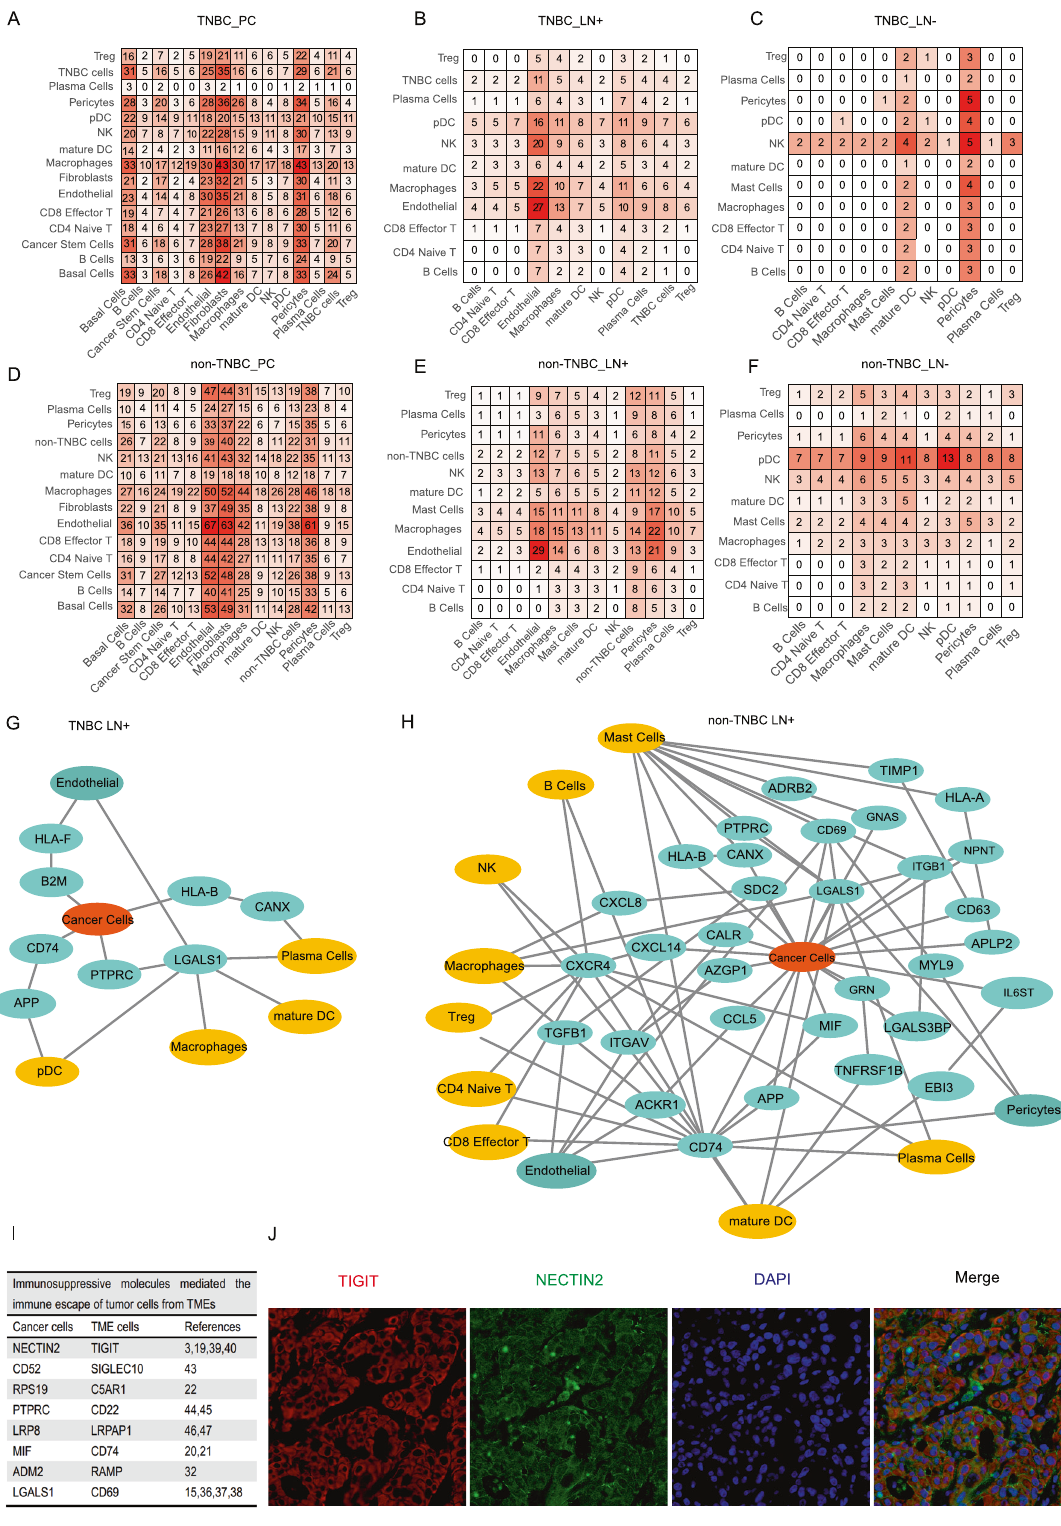
Fig. 6 Cell-to-cell communications between cancer cells and immune cells. A – F Heatmaps showing numbers of cell – cell interactions across cell types from variant sample origins. G, H NATMI networks showing ligand-receptor pairs among cells in lymph nodes with TNBC ( G ) and non-TNBC ( H ) cells. I Table showing impressive molecules and corresponding ligand-receptor pairs associated with breast cancer metastasis and the respective references. J Immuno fl uorescence staining of NECTIN2-TIGIT pair in lymph nodes with cancer